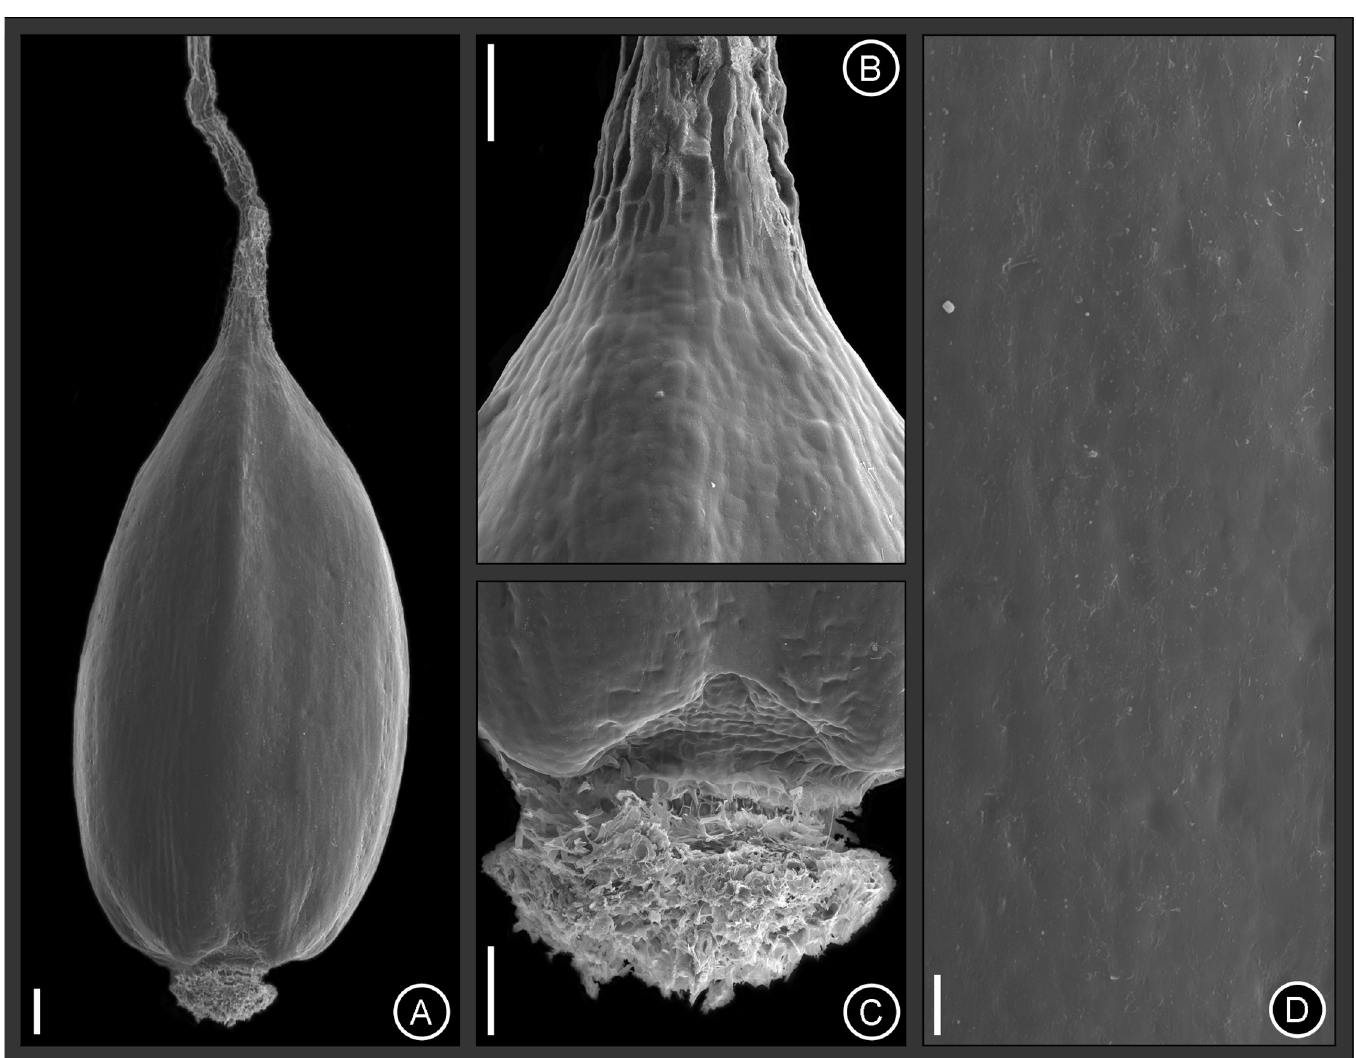
Fig 6. Micrographs taken by Scanning Electron Microscopy (SEM) from the achene surface of Cyperus prophyllatus , sp . nov . Taken from holotype A . R . O . Ribeiro et al . 487 (CVRD). (A) Entire view showing style persistent at apex. (B) Achene apex. (C) Achene base. (D) Detail of the Achene surface. Scale bars: A. 100 μ m. B–C. 50 μ m. D. 10 μ